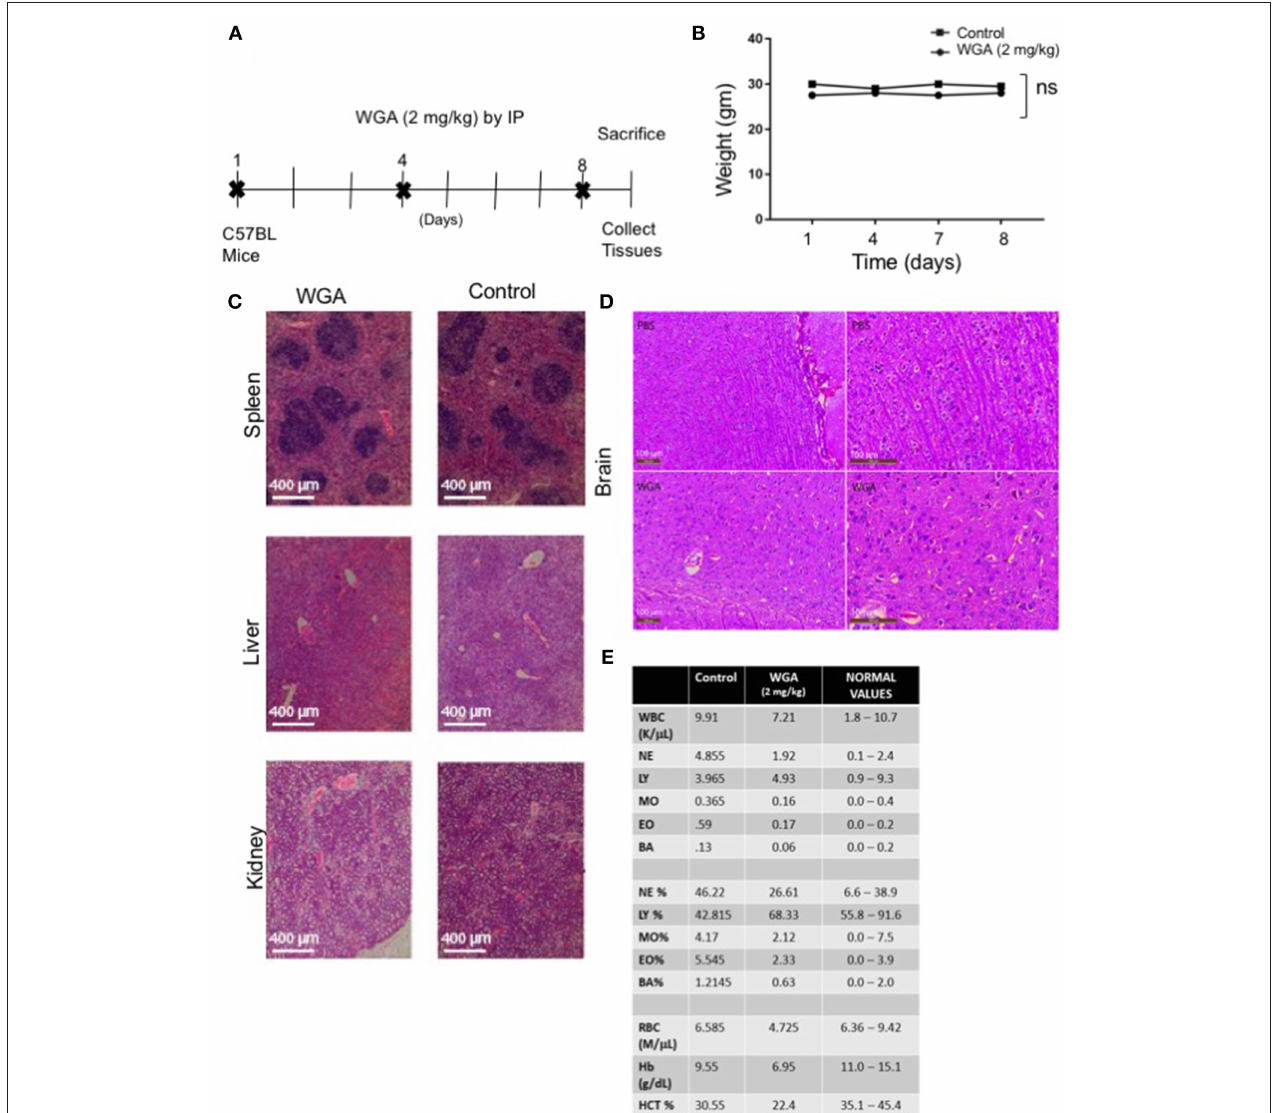
FIGURE 6 | WGA treatment demonstrated little toxicity to normal cells in vivo . (A) Treatment scheme where 2 mg/kg WGA was IP administered to two mice on days 1, 4, and 8. Mice were sacrificed on day 9. (B) Weights of mice treated with WGA during duration of treatment. (C) Histological analysis of WGA-treated tissues. Spleen, liver, and kidney stained with H&E and imaged by light microscopy at 10X magnification. Scale bar 400 µ m shown (D) Histological analysis of Hematoxylin&Eosin stained brain tissues from PBS and WGA (5 mg/kg) injected mice. Scale bar 100 µ m shown (E) HEMAVET blood toxicity analysis of treated mice after sacrifice compared to control mice and normal values. Normal values were given with HemaVet instructions. ns >